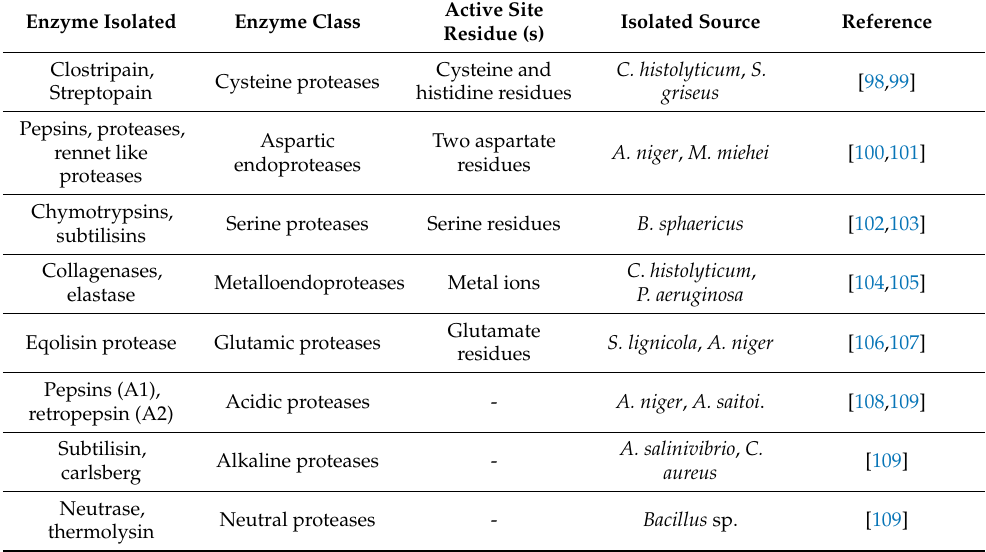
Neutral proteases